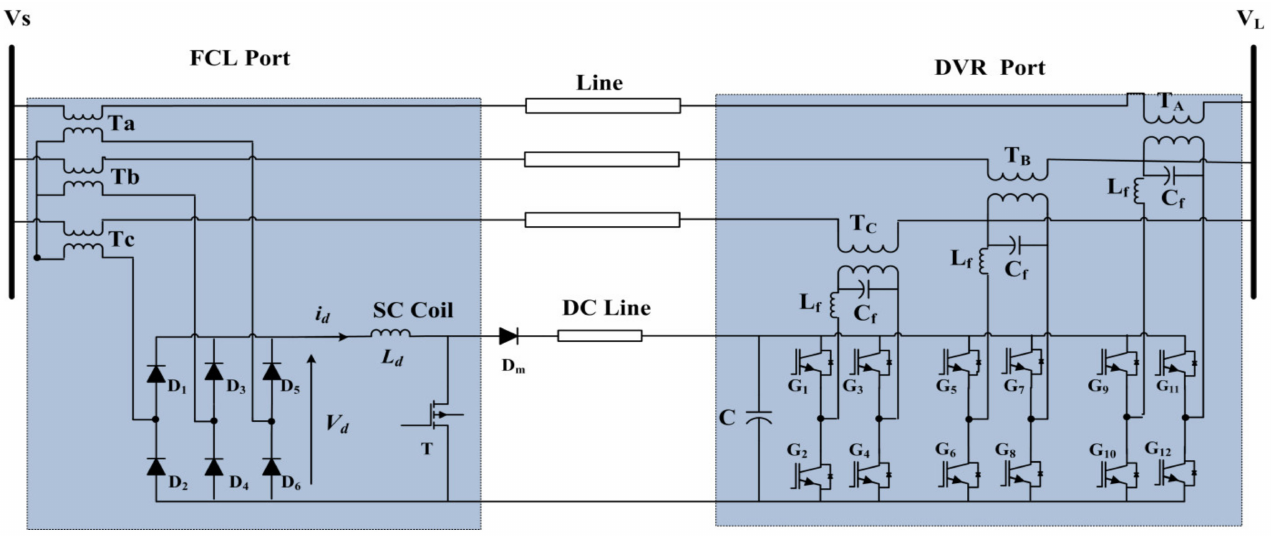
Figure 4. Proposed